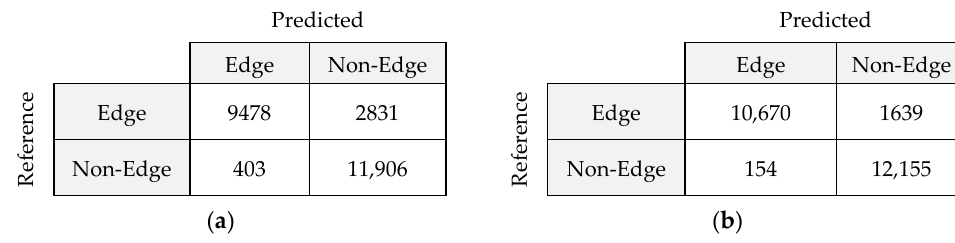
Figure 12. Confusion matrix from ( a ) SAE ( b ) GFSAE for the CEF dataset. Comparing Figures 12 a and b shows that using a guided filter in the post-process step can restore 42% of missing edges in SAE and also remove 62% of extra pixels. Table 6 presents accuracy metrics obtained from confusion matrices. Table 6. Accuracy metrics of boundary areas for SAE and GFSAE for the CEF dataset.